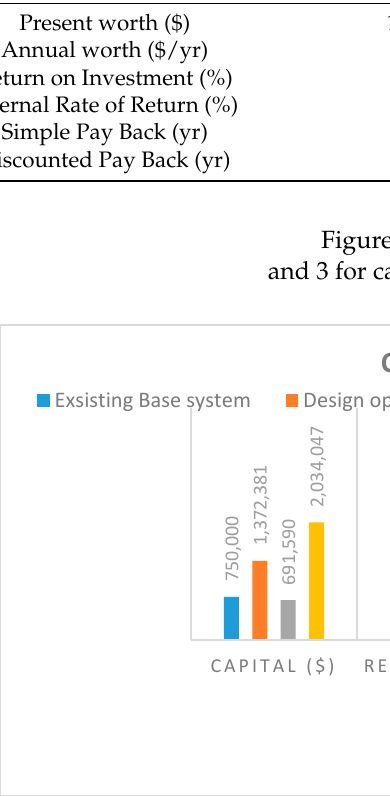
Table 11. Comparison of NPC, LCOE, and Operating Cost (OC).